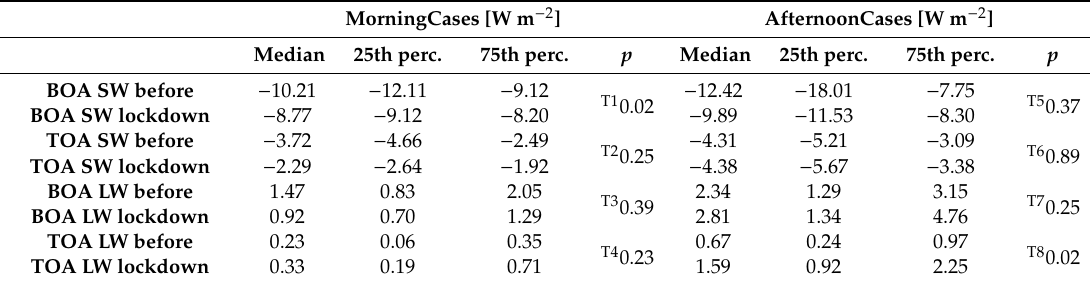
Table 6. Median, 25th, and 75th percentiles and p values from the Mann–Whitney analysis for the 8 comparisons. The superscripts in the p values stand for the test